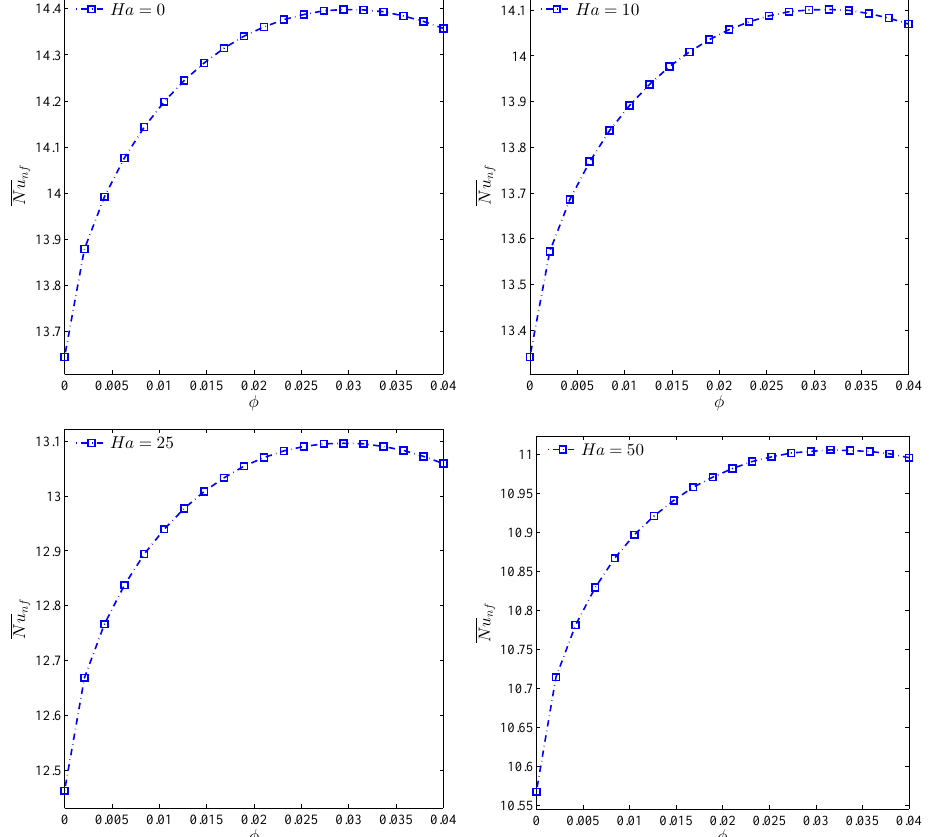
Figure 13. Plots of the average Nusselt number vs. φ for different Ha at Ri = 10 and D = 0.3.